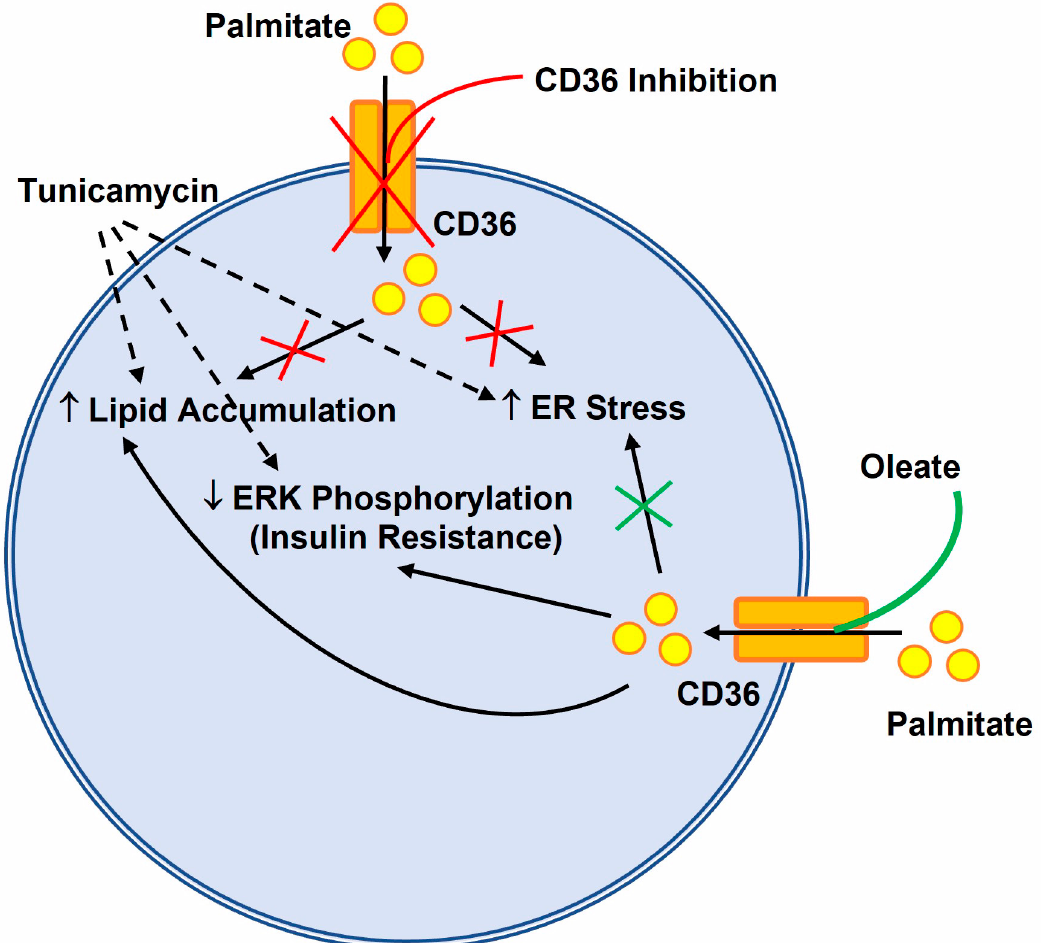
Figure 7. Graphical representation of palmitate induced ER stress and insulin resistance in cells. Palmitate, similar to tunicamycin, elicits an increase in lipid accumulation and ER stress with a concomitant decrease in ERK phosphorylation leading to insulin resistance. Inhibition of CD36 prevents palmitate induced lipid accumulation and ER stress in the cells. Treatment with oleate prevents only palmitate induced ER stress but does not restore ERK phosphorylation or insulin resistance in the cells.